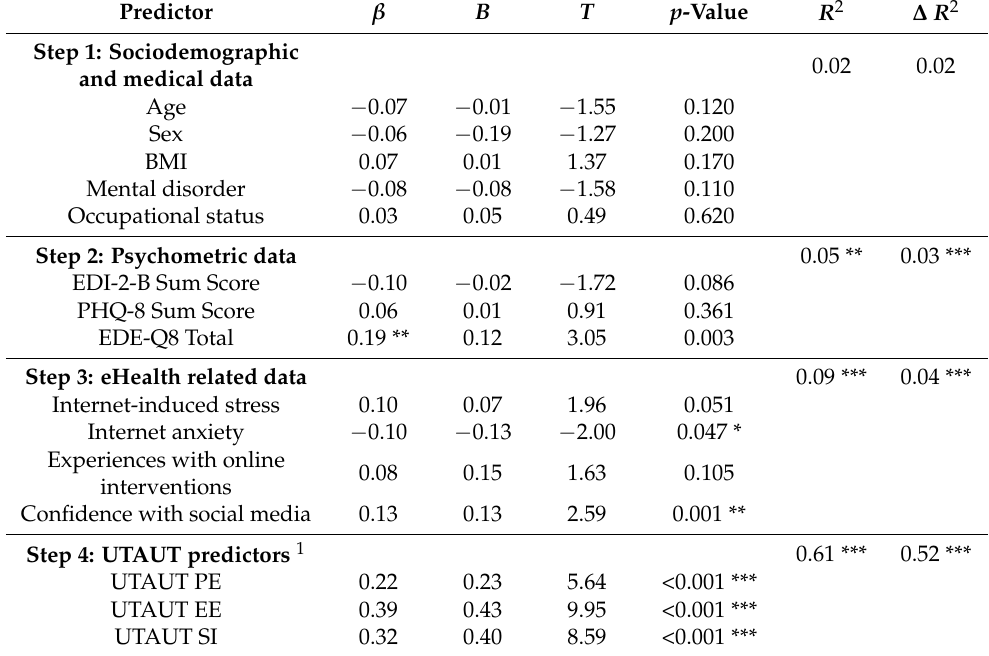
Table 3. Summary of hierarchical regression model for variables predicting acceptance of weight management applications (extended UTAUT